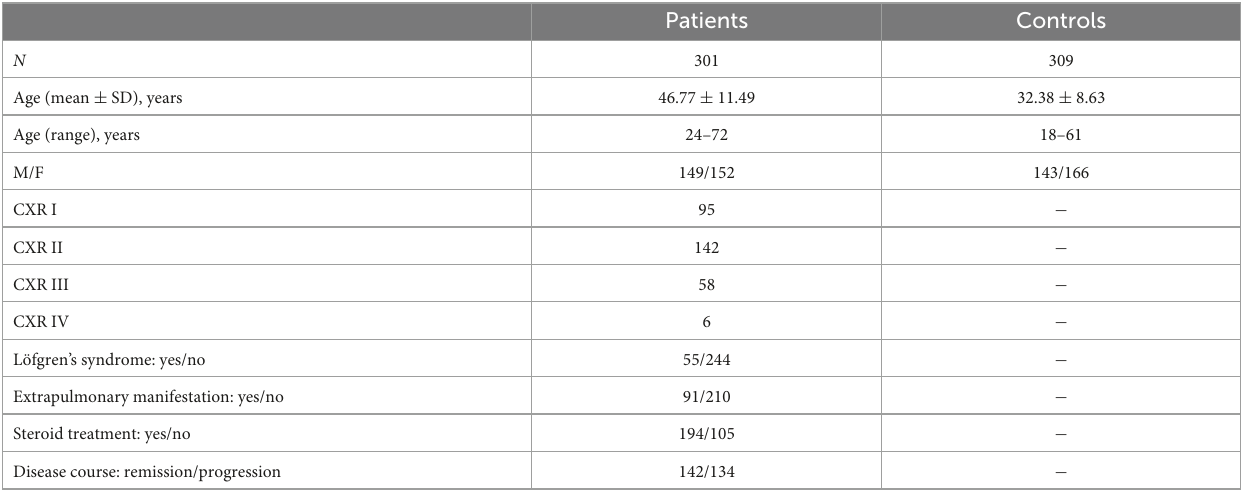
TABLE 1 Characteristics of the patients and healthy control subjects enrolled in the study.